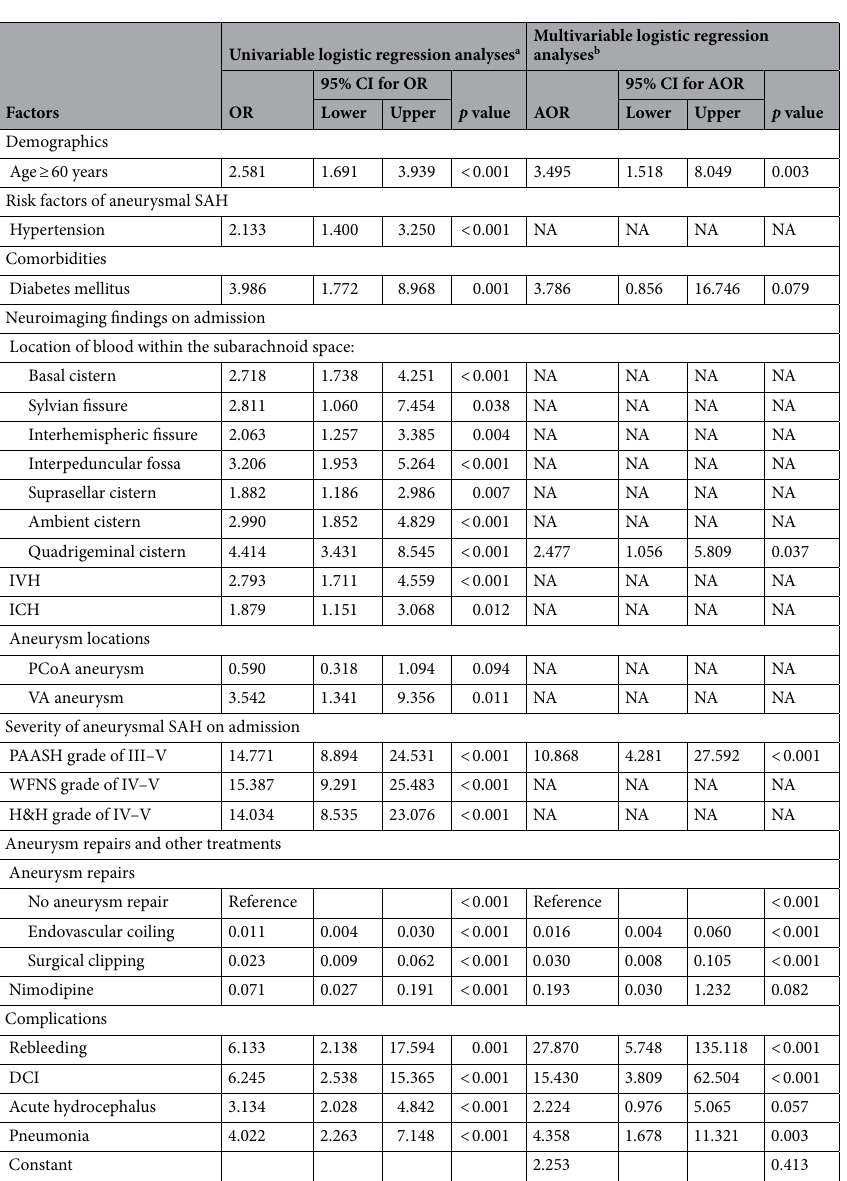
Table 6. Factors associated with 90-day poor outcomes in patients with aneurysmal subarachnoid haemorrhage: logistic regression analyses. AOR adjusted odds ratio, CI confidence interval, DCI delayed cerebral ischemia, H&H Hunt and Hess, ICH intracerebral haemorrhage, IVH intraventricular haemorrhage, mRS modified Rankin Scale, NA not available, OR odds ratio, PAASH Prognosis on Admission of Aneurysmal Subarachnoid Haemorrhage, PCoA posterior communicating artery, SAH subarachnoid haemorrhage, VA vertebral artery, WFNS World Federation of Neurosurgical Societies. a Each variable of the demographics, risk factors for aneurysmal SAH, comorbidities, initial clinical, neuroimaging and laboratory characteristics, the severity of aneurysmal SAH (i.e., the grades of PAASH, WFNS, and H&H grading scales that were either greater than or equal to the cut-off value) on admission, treatments, and complications was analysed in the univariable logistic regression model and was considered in the multivariable logistic regression model if the p value was < 0.05 in univariable logistic regression analysis, as well as clinically crucial factors. b All selected variables were included in the multivariable logistic regression model with the stepwise backward elimination method. Variables, then, were deleted stepwise from the full model until all remaining variables were independently associated with poor